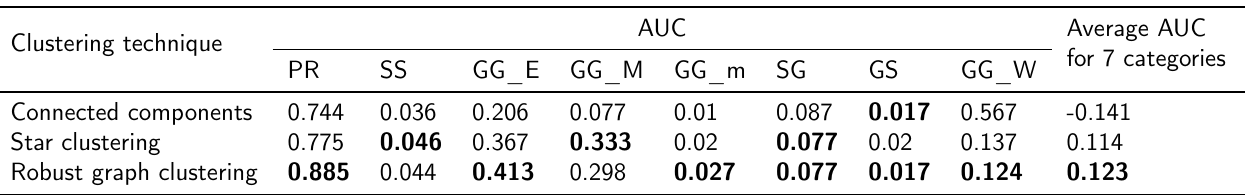
Table 6: Table 6: Area under the curve (AUC) values for the three clustering techniques ( Names only, unweighted attribute combination) with the best value(s) highlighted in each